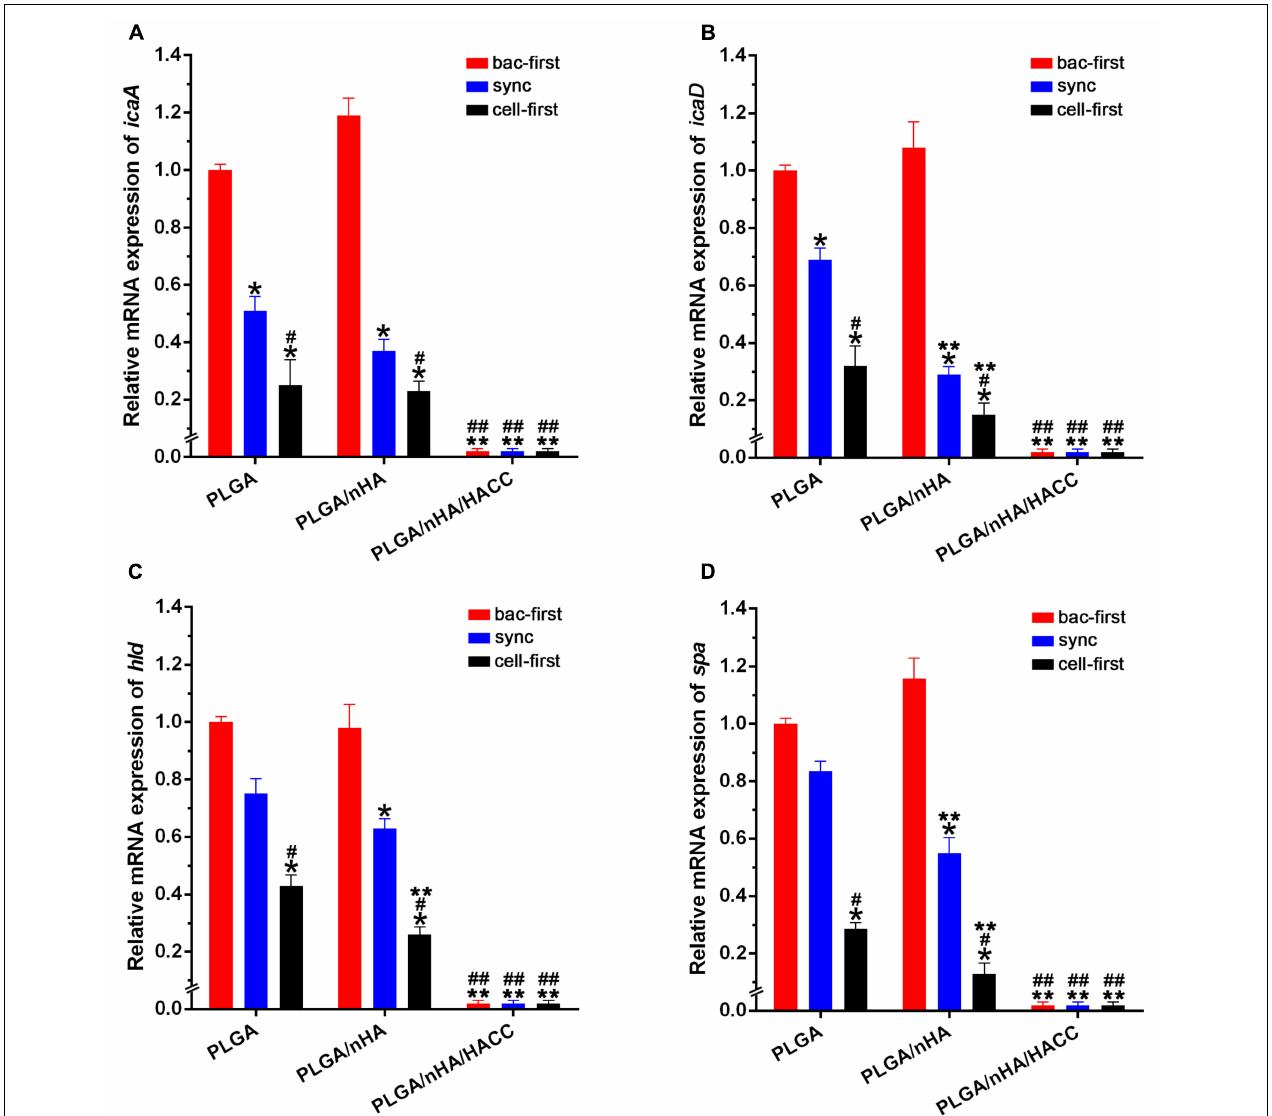
FIGURE 7 | Real-time PCR analysis of bacterial biofilm-related gene transcription. (A–D) The expression levels of icaA , icaD , hld and spa normalized to the 16S rRNA gene in biofilm formation by S. aureus on different materials surfaces in different co-cultured systems. The mRNA levels shown are the relative mRNA level compared to the mRNA level in the PLGA (bac-first) group. ∗ p < 0.05 compared with bac-first group on the same surface. # p < 0.05 compared with sync group on the same surface. ∗∗ p < 0.05 compared with PLGA group in the same co-cultured system. ## p < 0.05 compared with PLGA/nHA group in the same co-cultured